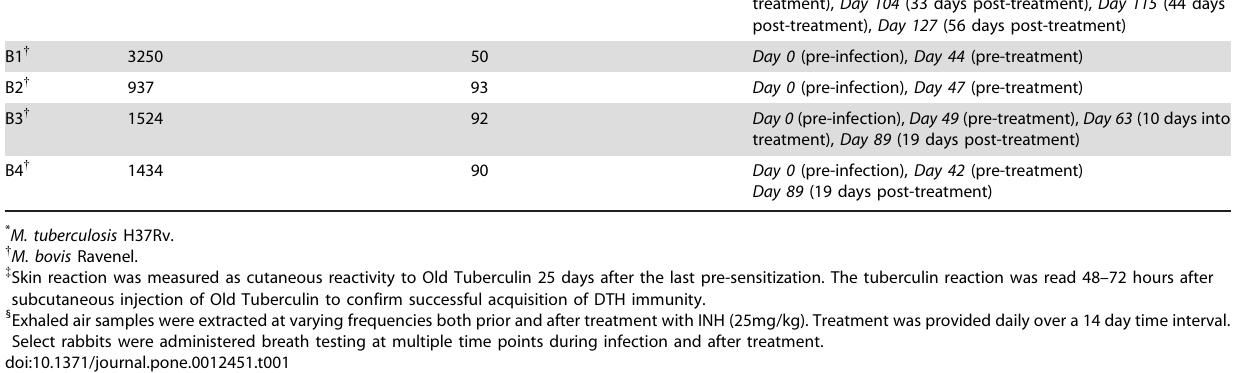
Rabbit Skin Reaction (mm 3 )